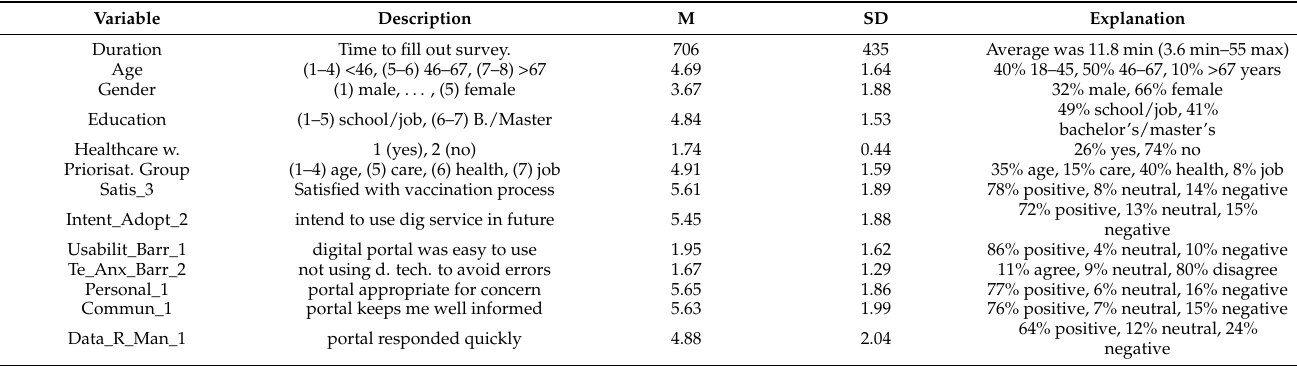
Table 1. Descriptive Results of Digital Vaccination Management Survey.